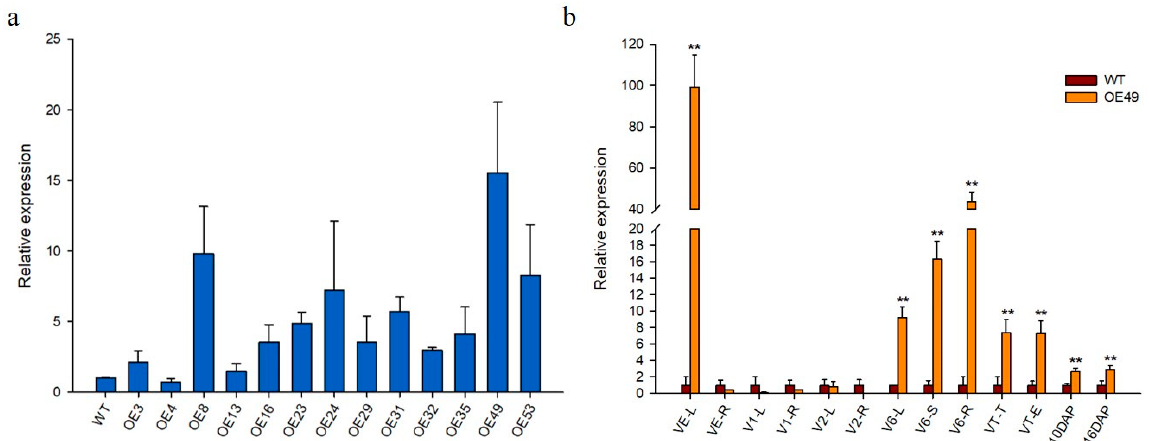
Figure 2. ( a ) Relative expression of ZmCYCB1-1 in the 13 transgenic lines and wild type (WT). ( b ) Relative expression levels of ZmCYCB1-1 normalized to WT in different growth stages in OE49. L: leaves; R: roots; S: stems; T: tassel; E: ears. Students t test, ** p < 0.01. The expression level of ZmCYCB1-1 in WT in ( a , b ) set to 1.